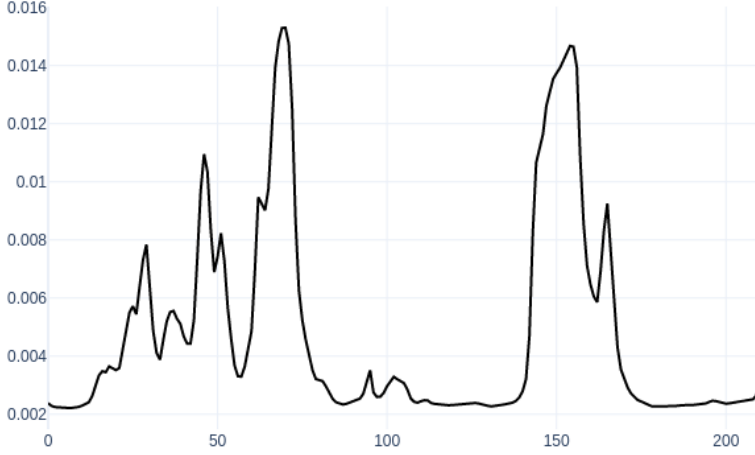
Figure 3. An attention graph (frames vs weights) for a segment of